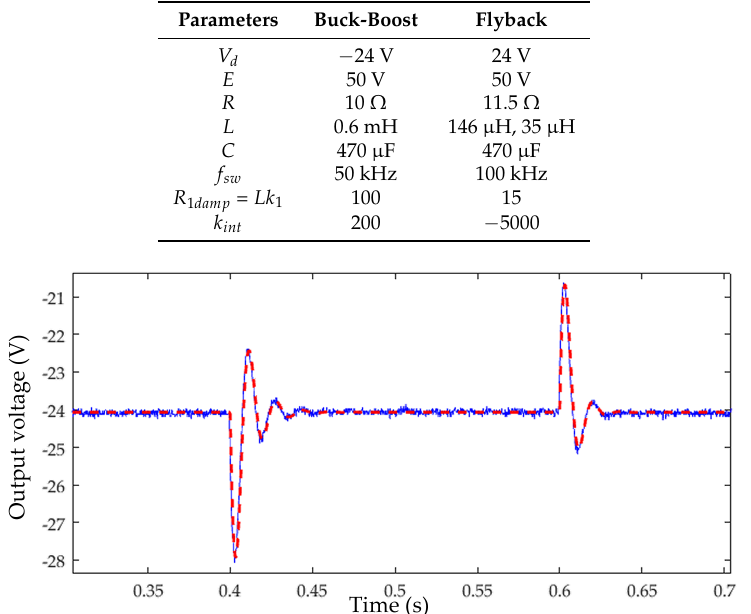
Figure 16. Open loop control comparing SHIL (blue line) with Software Simulation (red line) results for Buck-Boost converter. Normalized output voltage x 2 for load perturbation (70–100%) using fixed d = 0.325.